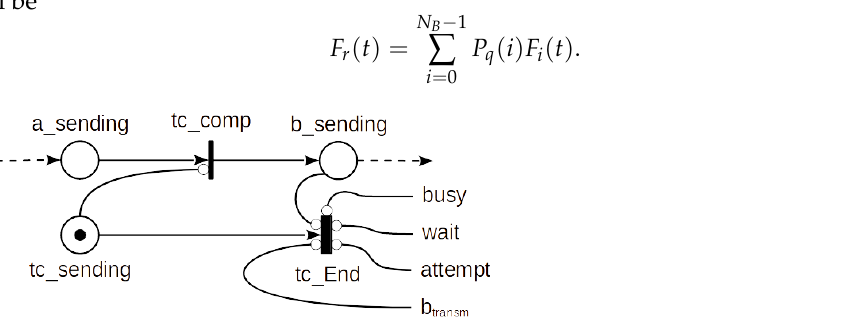
Figure 6. Modification to the performance model by implementing the tagged customer technique.